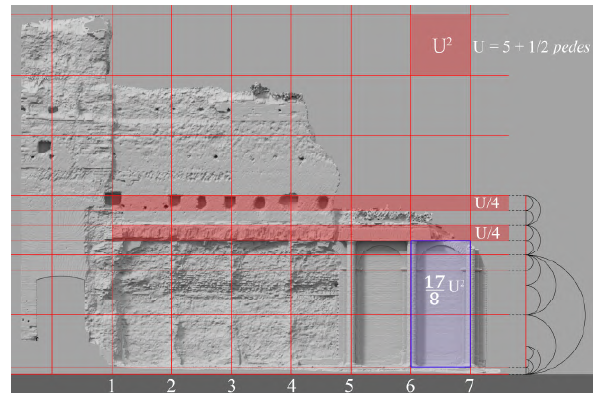
Figure 10. Façade design of the Golden Court.